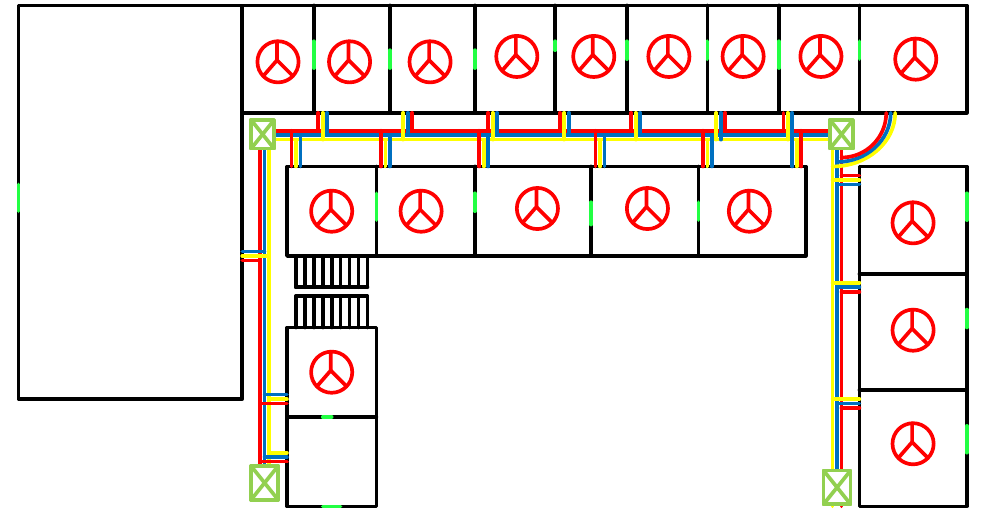
Figure 6. Sketch of the Faqir API Hostel (2nd floor). Table 4. Faqir API Hostel (ground floor) existing load